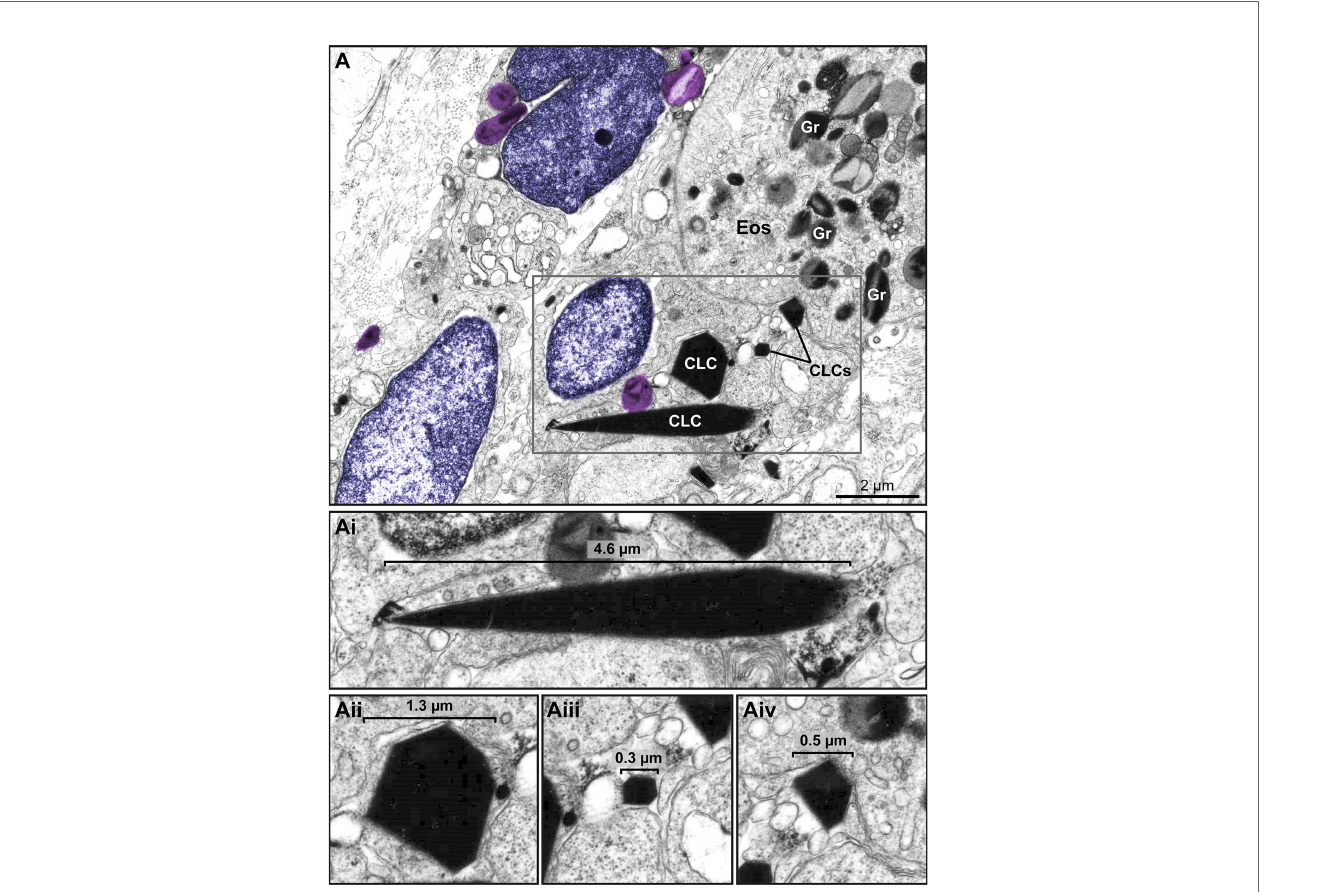
FIGURE 9 | Charcot Leyden crystals (CLCs) are frequently seen in in fl ammatory sites from eosinophil-associated diseases (EADs) in association with EETosis. (A) CLCs displaying varied shapes and sizes are observed by TEM in a biopsy (intestine) of a patient with UC. Large and very small CLCs can be observed in the same microenvironment. Note free-extracellular granules (FEGs, colored in light purple) close to CLCs, an intact eosinophil (Eos), and decondensing nuclei (colored in purple). (Ai-Aii) CLCs within the boxed area in (A) seen individually in higher magni fi cation to highlight their different